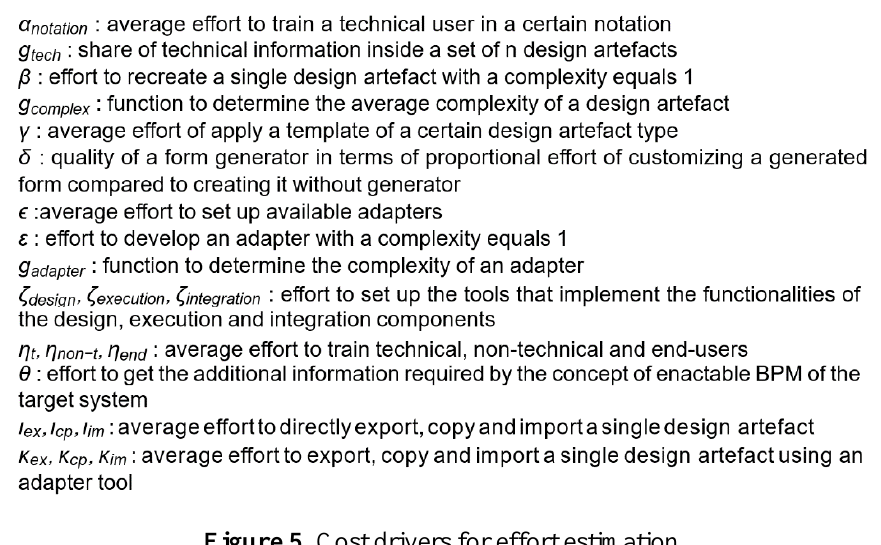
Figure 5. Cost drivers for effort